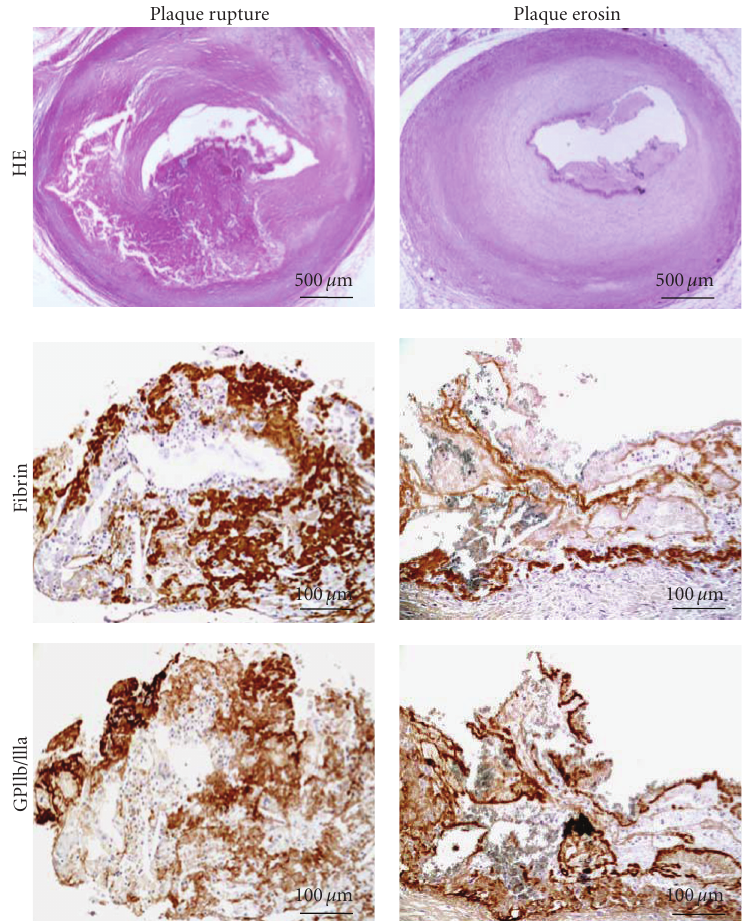
Figure 2: Coronary plaque rupture and erosion with thrombi. Large necrotic core and disrupted thin fibrous cap is accompanied by thrombus formation in ruptured plaque. Eroded plaque has superficial injury of SMC-rich atherosclerotic lesion with thrombus formation. Both thrombi comprise platelets and fibrin. HE, hematoxylin eosin stain (from Sato et al. [4] with